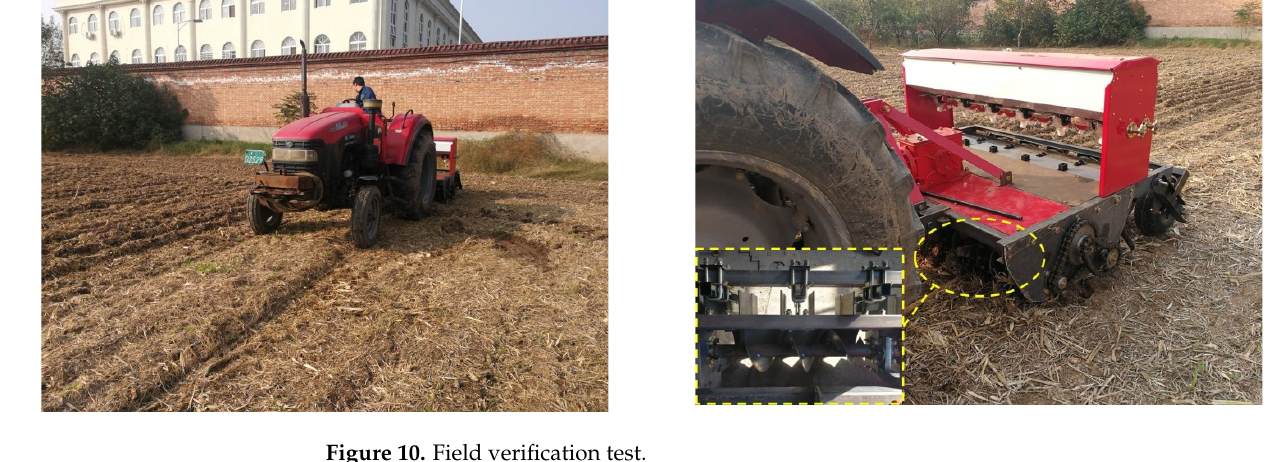
Figure 10. Field verification test.